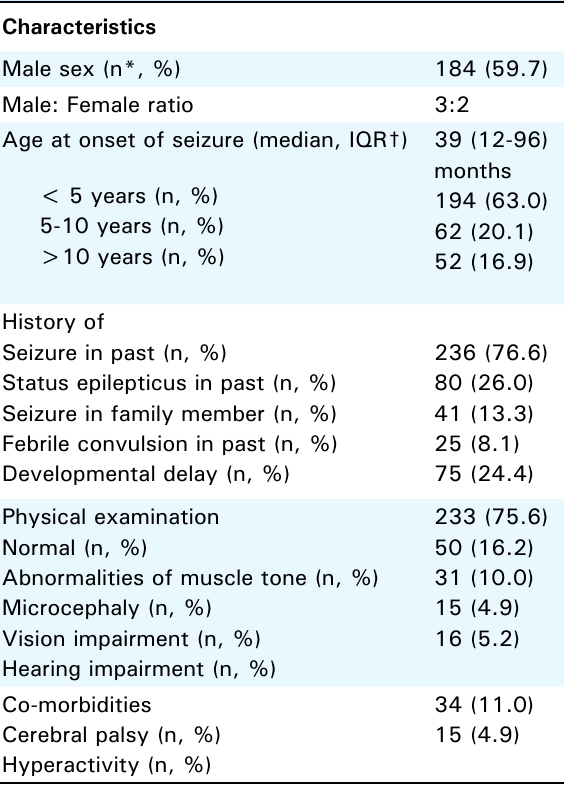
Table 1. Baseline characteristics of